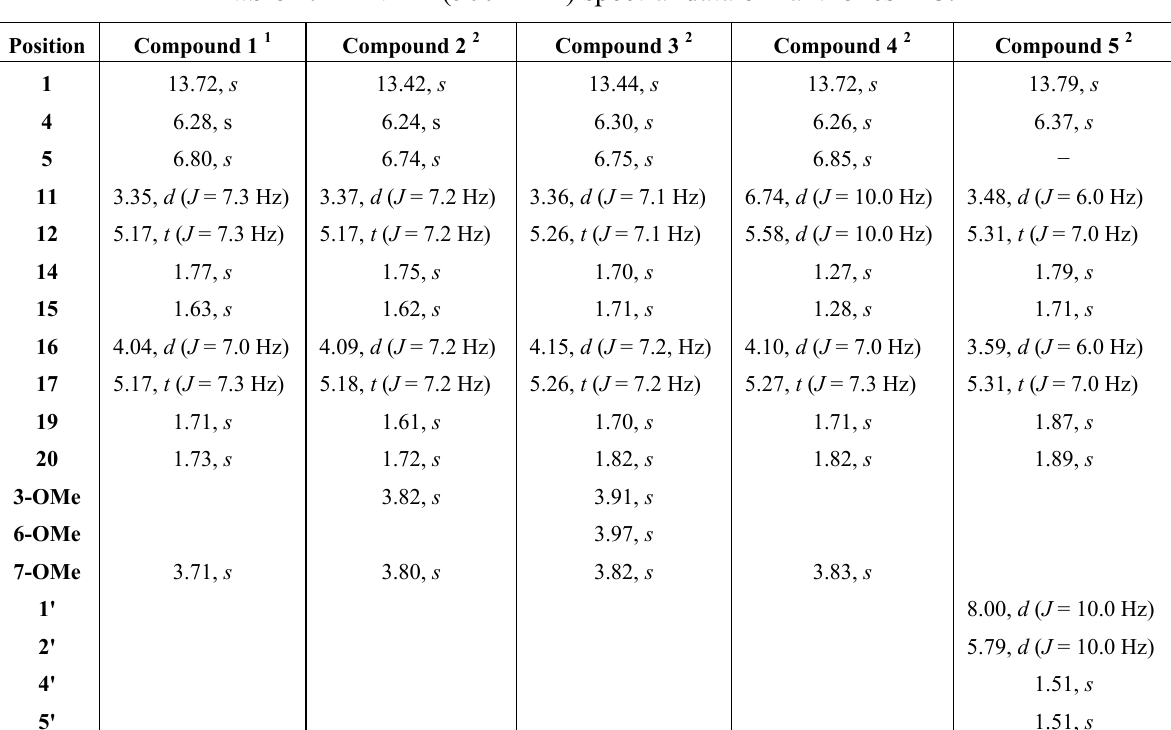
Table 1. 1 H-NMR (500 MHz) spectral data of xanthones 1 – 5